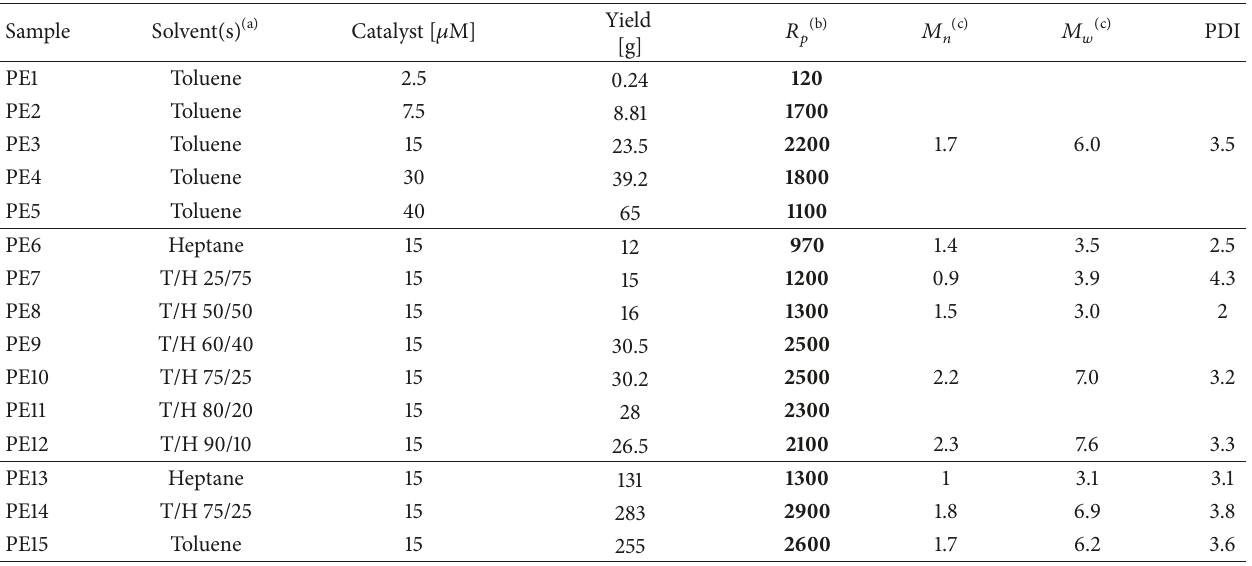
Table 1: Results of ethylene polymerization with 1/